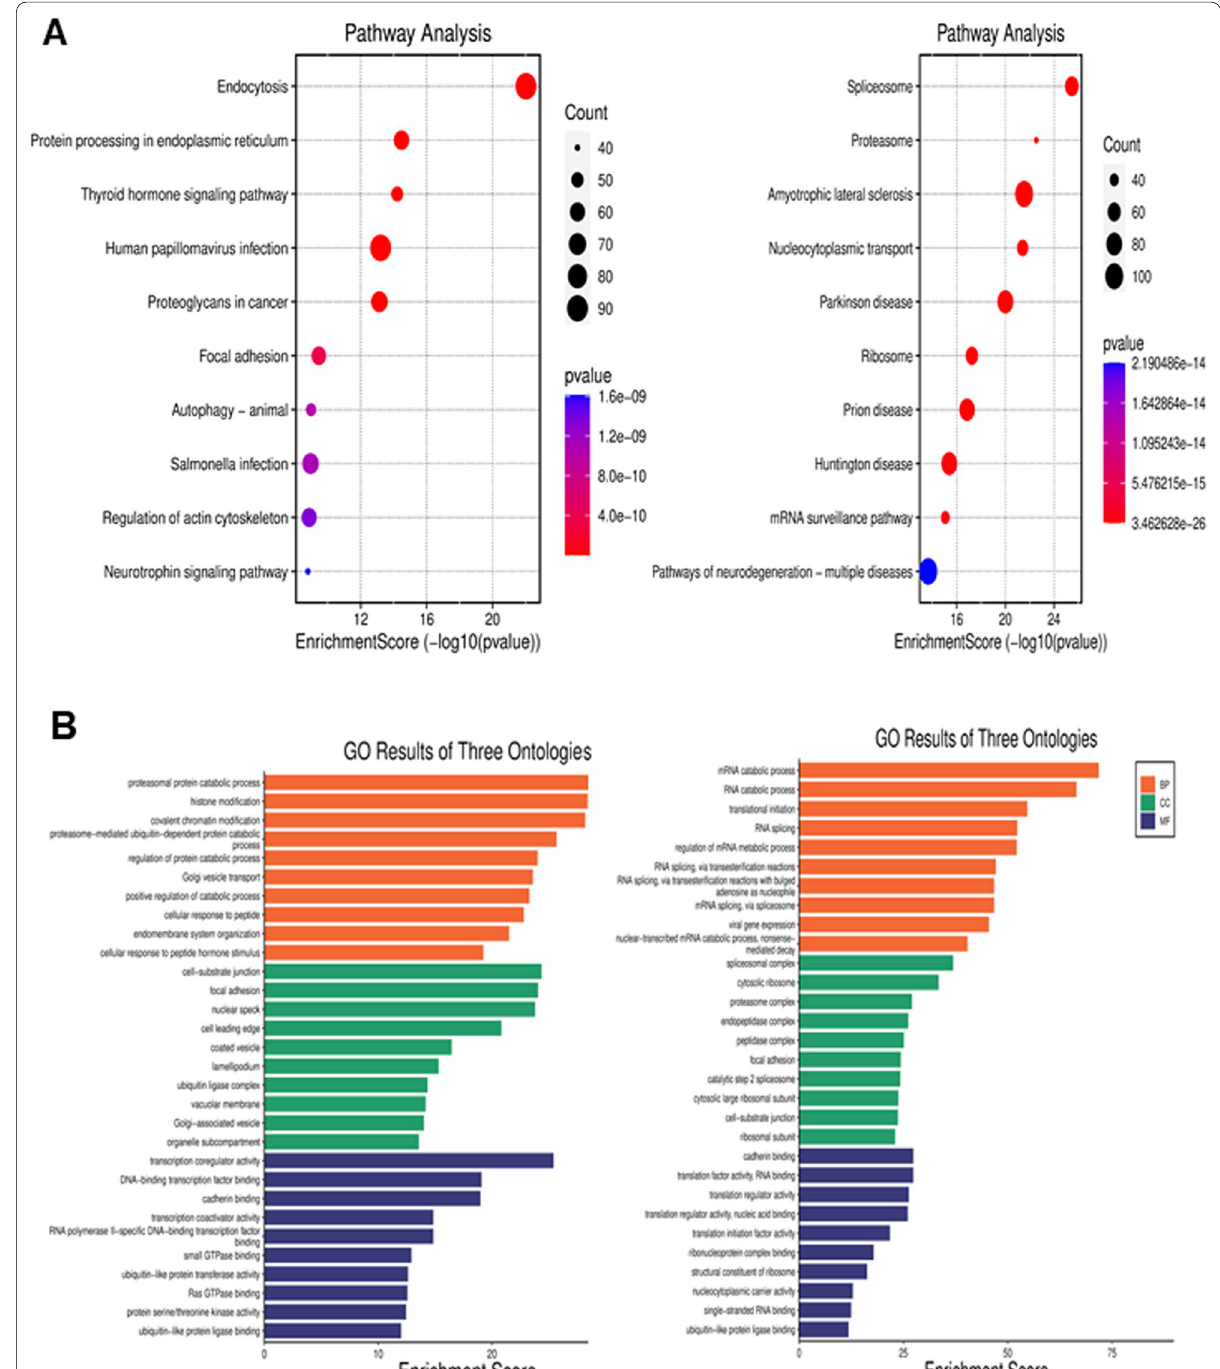
Fig. 3 The figure contains interactive bar charts displaying the results of the gene ontology enrichment analysis generated using Enrichr. The x axis indicates the log 10 ( p value) for each term. Significant terms are highlighted in −